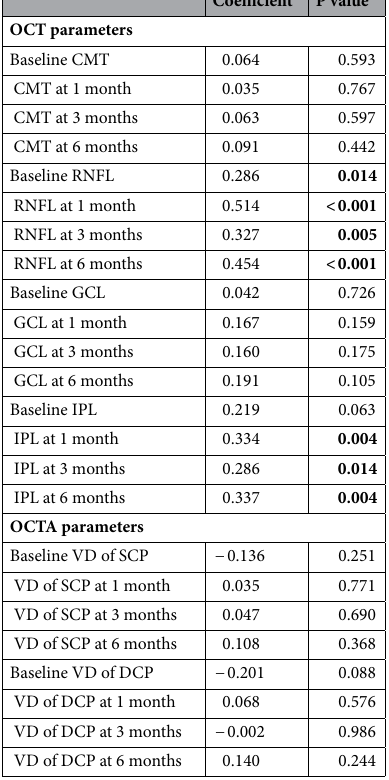
Table 5. Correlation between optical coherence tomography and optical coherence tomography angiography parameters and final best-corrected visual acuity. Values in boldface (P < 0.05) are statistically significant. OCT optical coherence tomography, CMT central macular thickness, RNFL retinal nerve fiber layer, GCL ganglion cell layer, IPL inner plexiform layer, OCTA optical coherence tomography angiography, VD vessel density, SCP superficial capillary plexus, DCP deep capillary